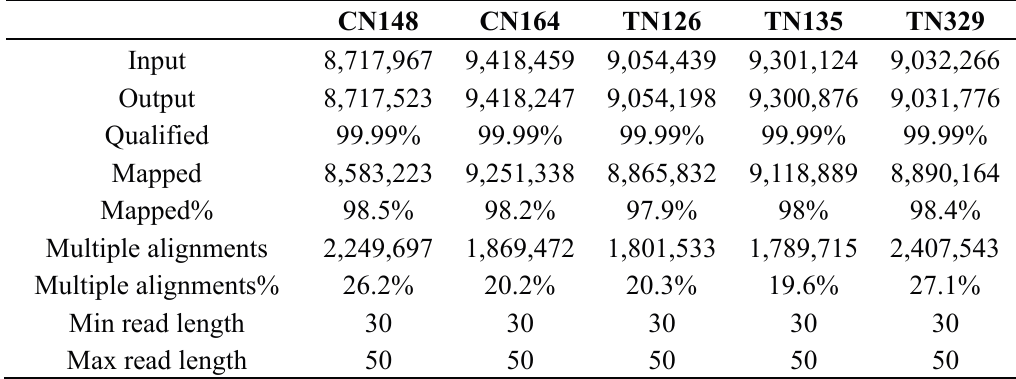
Table 2. The clean reads counts and alignment results of each